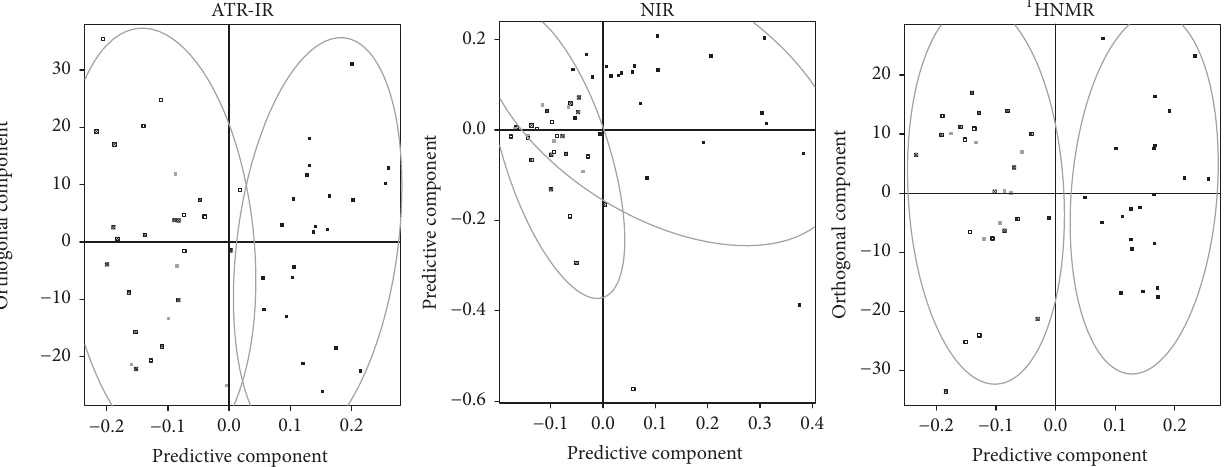
Figure 5: Scores plots of typical models for discrimination by origin. These models were chosen from the top of the curves in Figure 4 (left). By “typical” we mean that their 𝑄 2 values are the most frequent over the 100-model sample generated in the Monte Carlo validation. Black squares: Colombia and white squares: other